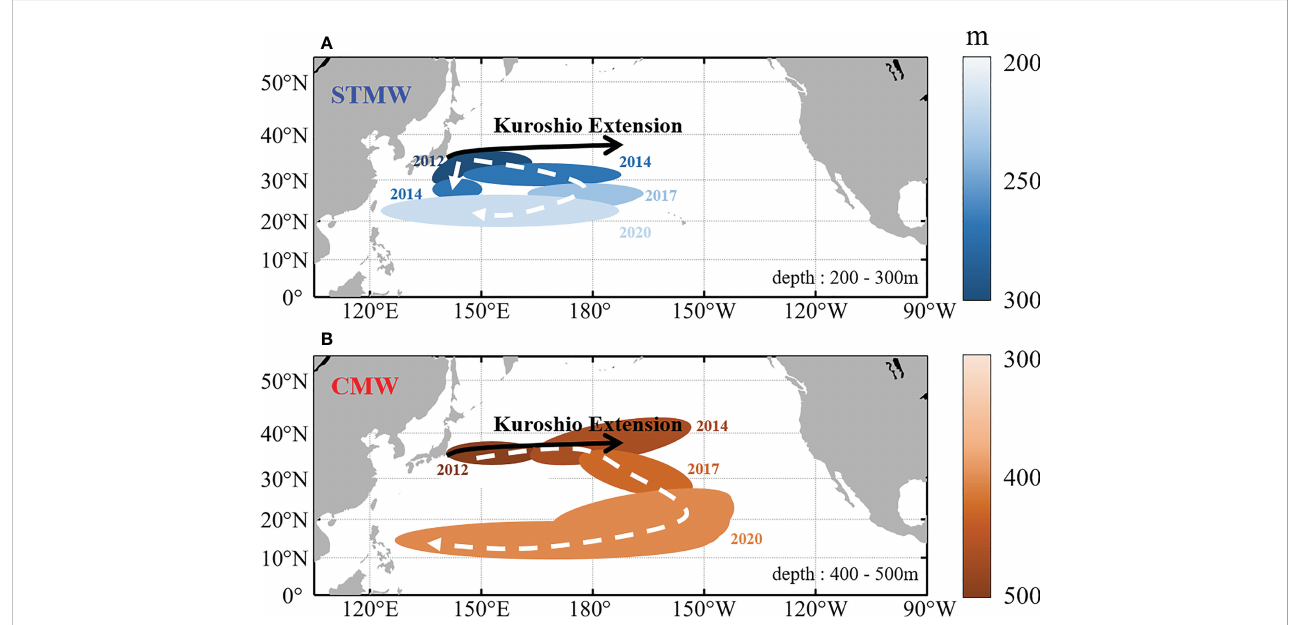
FIGURE 11 Schematic diagram of 137 Cs path induced by (A) STMW and (B) CMW. The area of the ellipse represents the distribution of 137 Cs, and the color roughly represents the